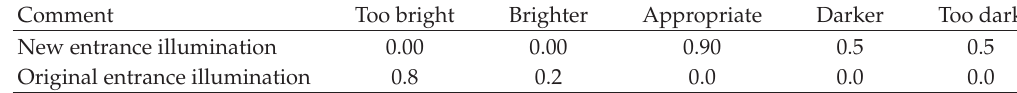
Table 4: Assessment results of easing lighting entrance